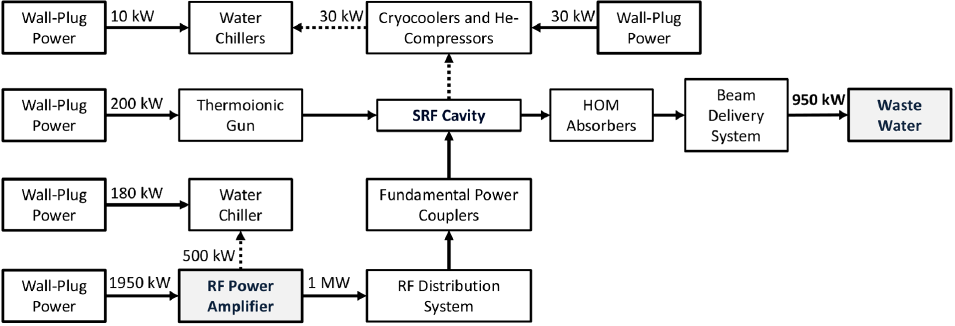
FIG. 27. Simplified energy flow